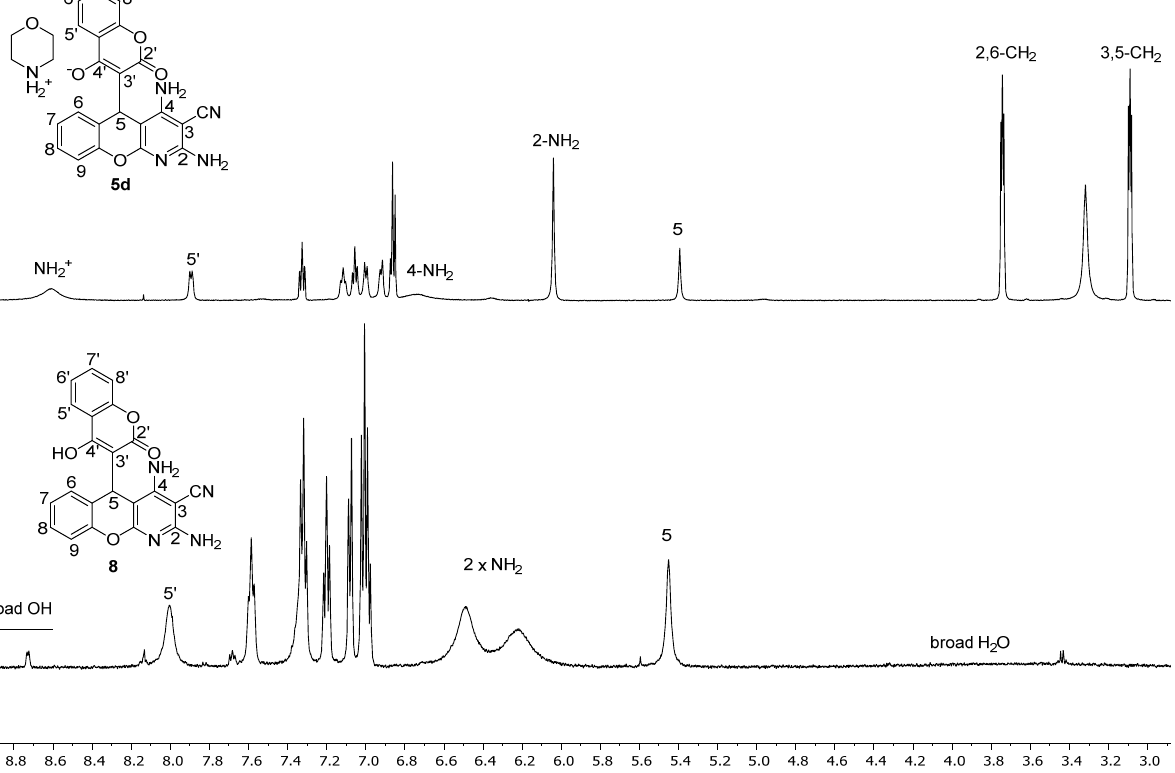
Figure 1. Fragment of 1 H NMR spectrum of compound 8 , DMSO- d 6 , 500 MHz (bottom); fragment of 1 H NMR spectrum of compound 5d , DMSO- d 6 , 600 MHz (top).